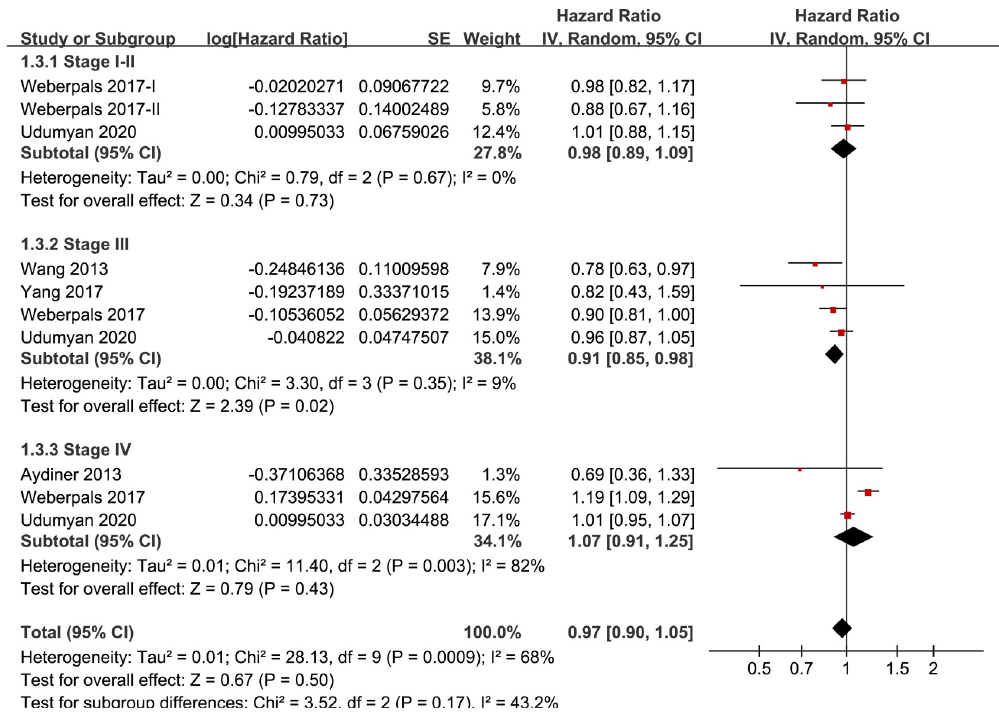
Fig 4. Stratified analyses for the meta-analysis of the association between BB use and OS of lung cancer according to the stage of the tumor.